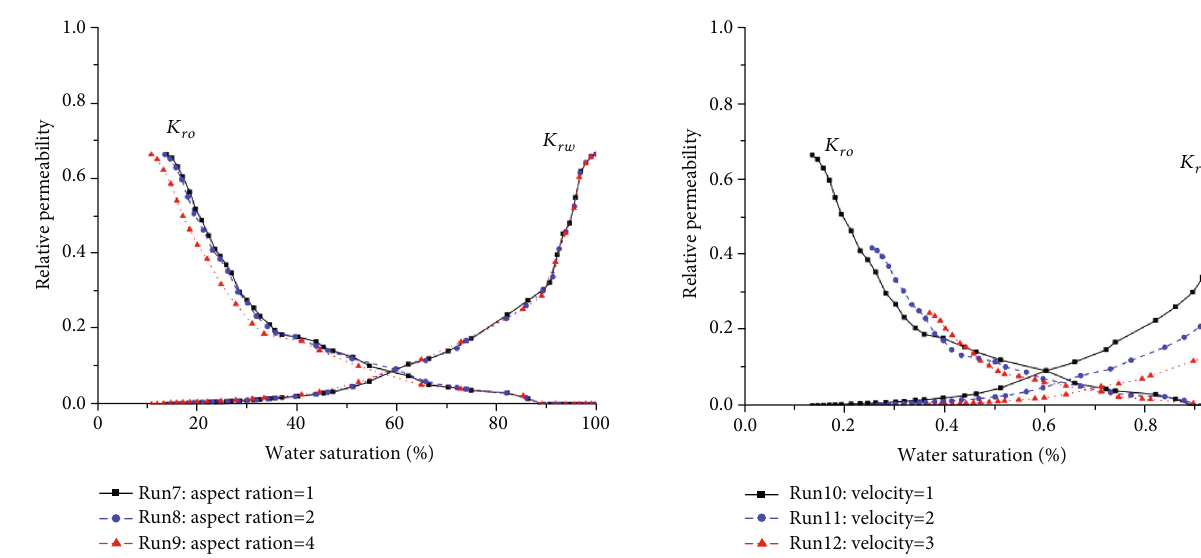
Figure 9: E ff ect of aspect ratio on relative permeability.